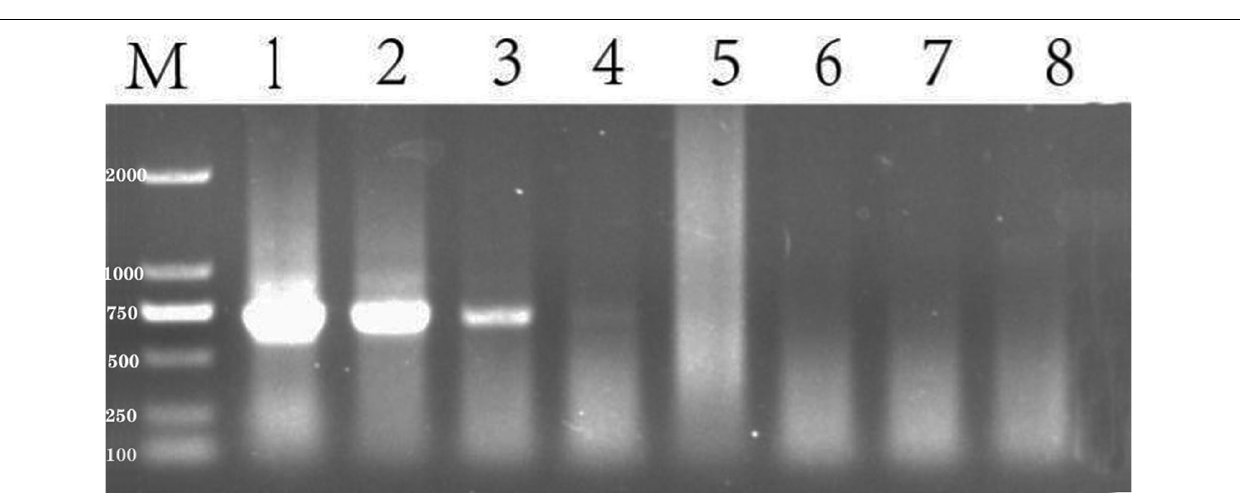
FIGURE 4 | Sensitivity of detection of S. reilianum using the SR3 primer pair. PCR products amplified from a 10-fold dilution series of S. reilianum genomic DNA and visualized on a 1% agarose gel. Lane 1:107 ng/ µ L, Lane 2: 10.7 ng/ µ L, Lane 3: 1.07 ng/ µ L, Lane 4: 1.07 × 10 − 1 ng/ µ L, Lane 5: 1.07 × 10 − 2 ng/ µ L, Lane 6:1.07 × 10 − 3 ng/ µ L, Lane 7:1.07 × 10 − 4 ng/ µ L. Lane M: DNA ladder